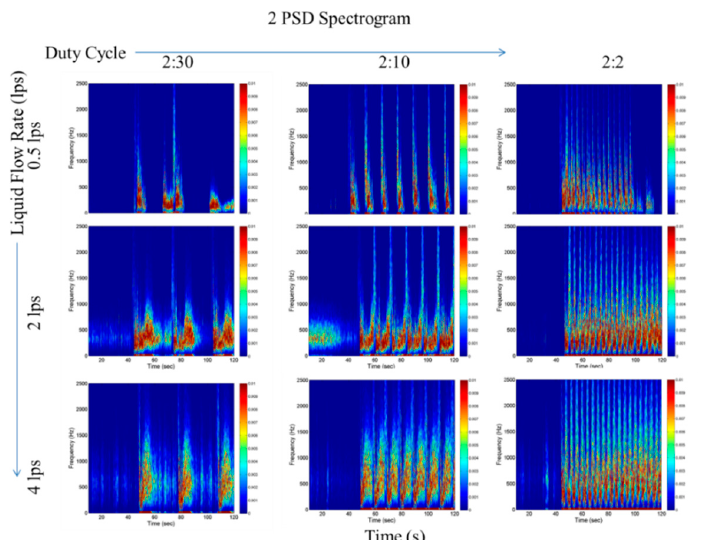
Figure 9. The STFT spectrogram showing PSD for various slug trains. Most slug fronts can be seen at higher Doppler frequencies (>1000 Hz), and most slower trail bubbles are in lower Doppler frequencies (<600 Hz). The Y-axis limits of each plot in this figure are 0 volts to 1 volt and the X-axis limits are 0 s to 120 s.